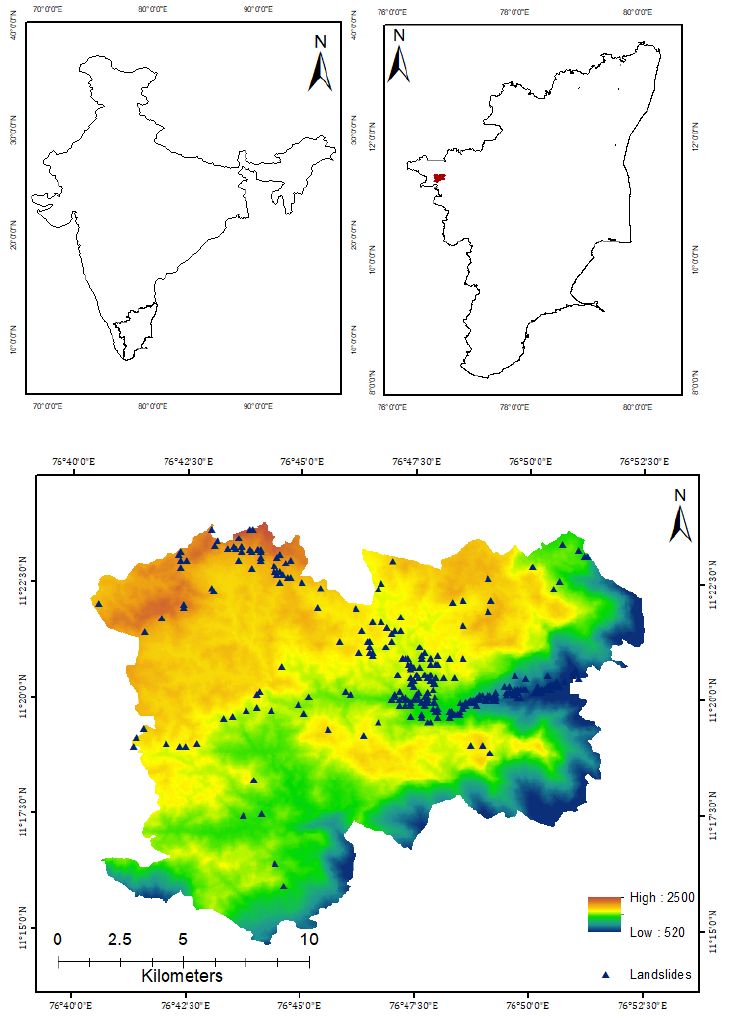
Figure 1. Location map of the study area showing the Digital Elevation Model of Coonoor Taluk, Tamil Nadu, India.